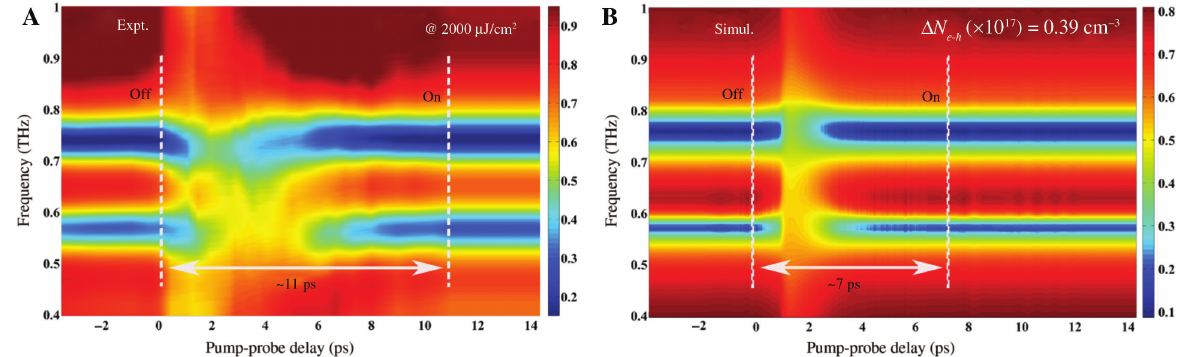
Figure 7: Transient evolution process of the fast switching changes in EIT resonance with the Ge film is activated. (A) Measured transmission spectra map of the hybrid photonic device vs. the pump-probe time delay. The entire photo-switching cycle of the active EIT resonance device in fast recovery speed is presented. The pump fluence is 2000 μ J/cm 2 . (B) The corresponding simulated result of the optical modulation process. The measured recombination curve of the nonequilibrium carriers (∆ N calculation by assuming the maximum ∆ N is 0.39 × 10 17 cm −3 . e-h